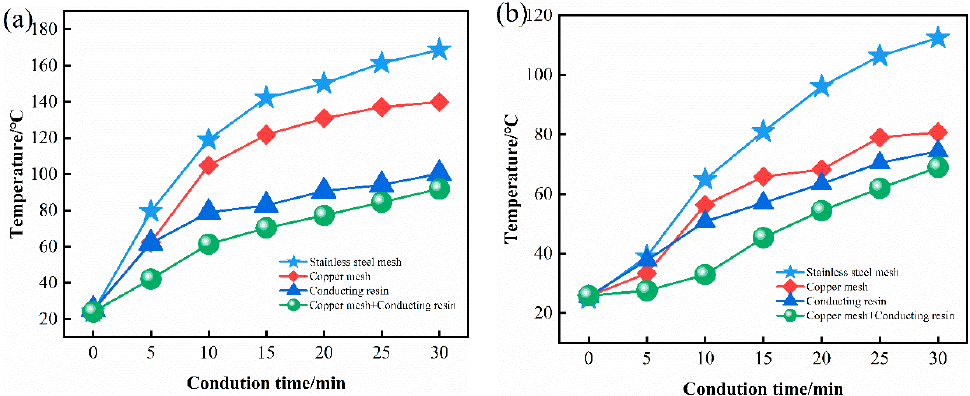
Figure 7. Temperature-time relationship of sliding plate under different contact modes. ( a ) Maximum temperature and ( b ) minimum temperature.